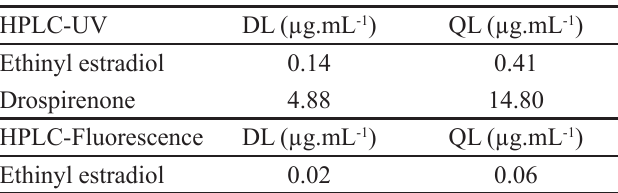
TABLE II - Results obtained for DL and QL by using two detectors: UV and fluorescence